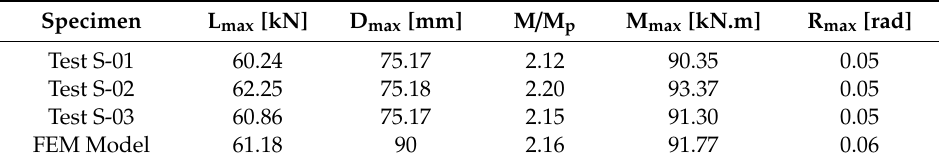
Table 7. Summary of maximum values obtained in tests and finite element (FE) model.